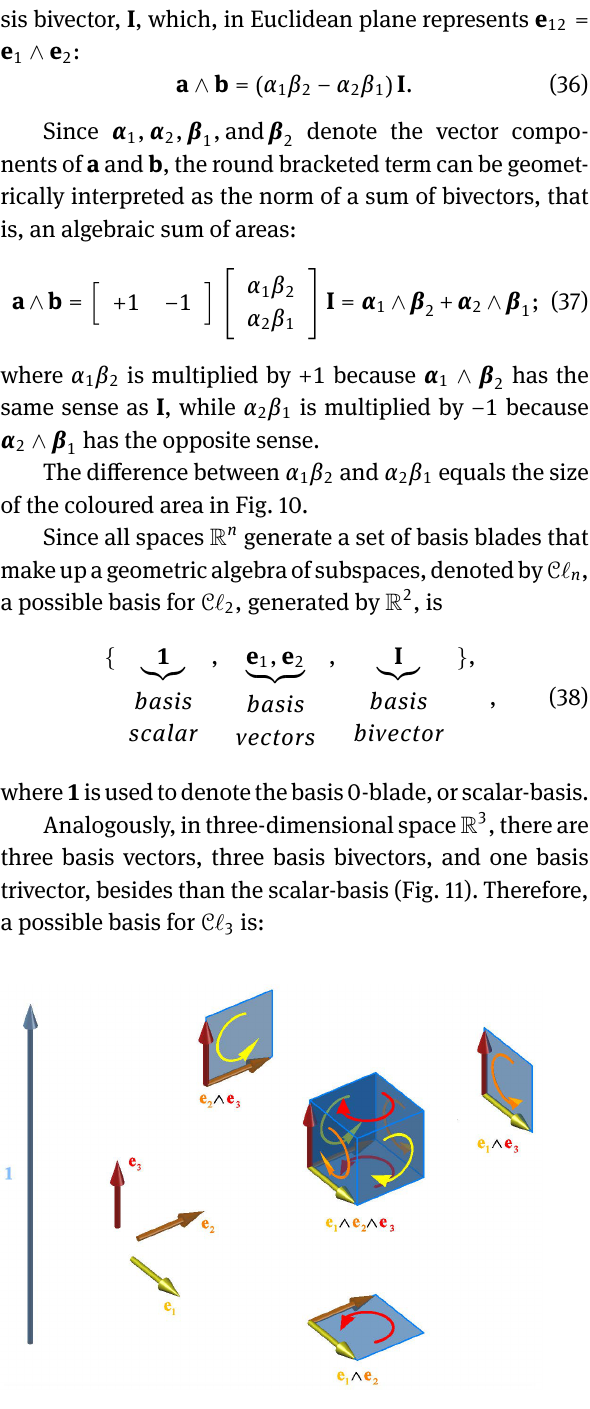
Figure 11: Standard n -v ector basis in 3D: unit scalar 1 (represented by a black number line), unit vectors, unit bivectors, and a unit trivector.